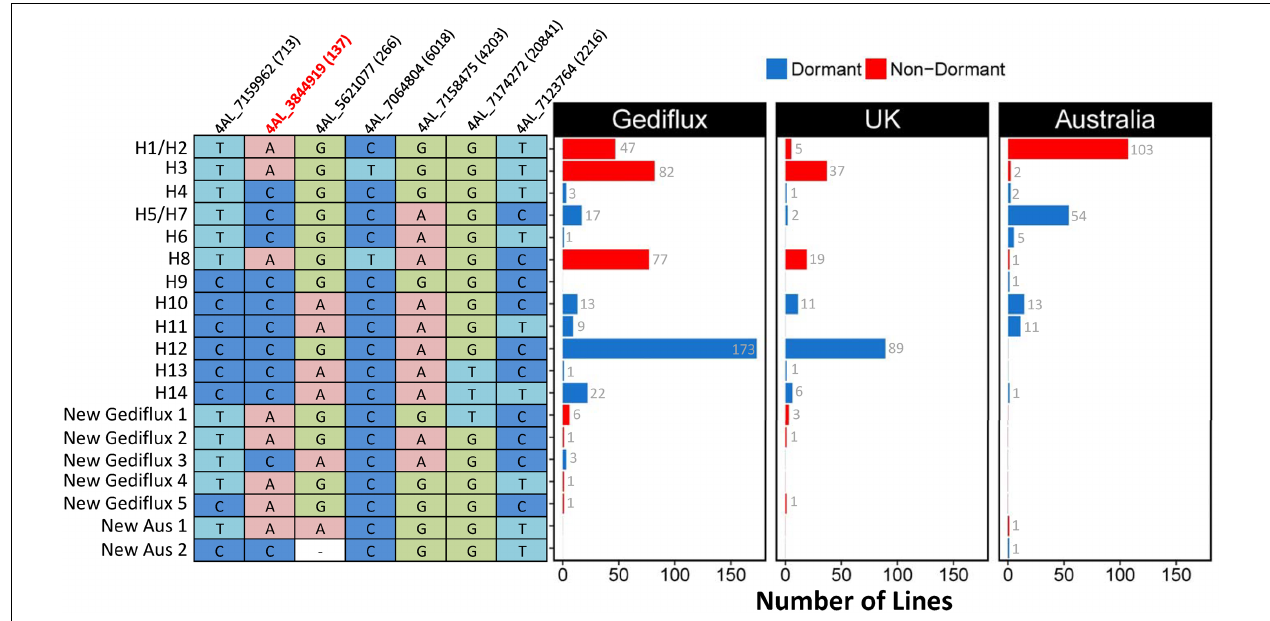
FIGURE 4 | Relationship between the European, United Kingdom, Australian and HapMap Phs-A1 Haplotypes. The distribution (bar charts) of the HapMap and unique haplotypes found in the Gediflux (European), United Kingdom and Australian germplasm using genotype information of seven of the 39 HapMap SNPs within the Phs-A1 interval. Red bars correspond to the non-dormant “A” allele, whereas blue bars correspond to the dormant “C”